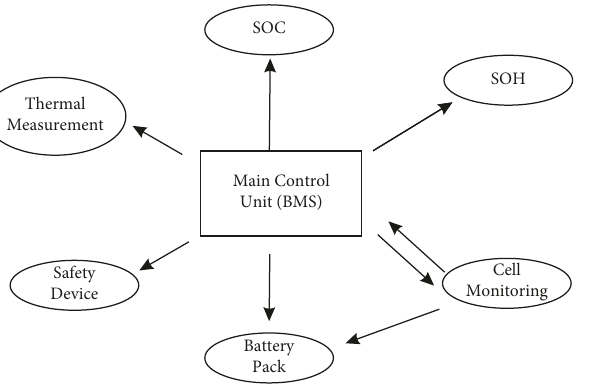
Figure 7: Function of BMS in EV cell monitoring. Figure 9: Function of low voltage BMS.